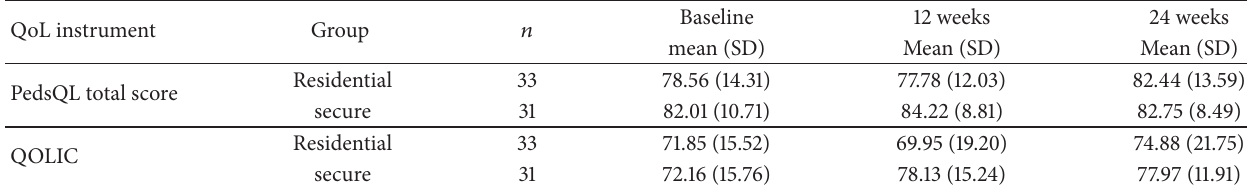
Table 1: Mean cores and standard deviations of the PedsQL total score and